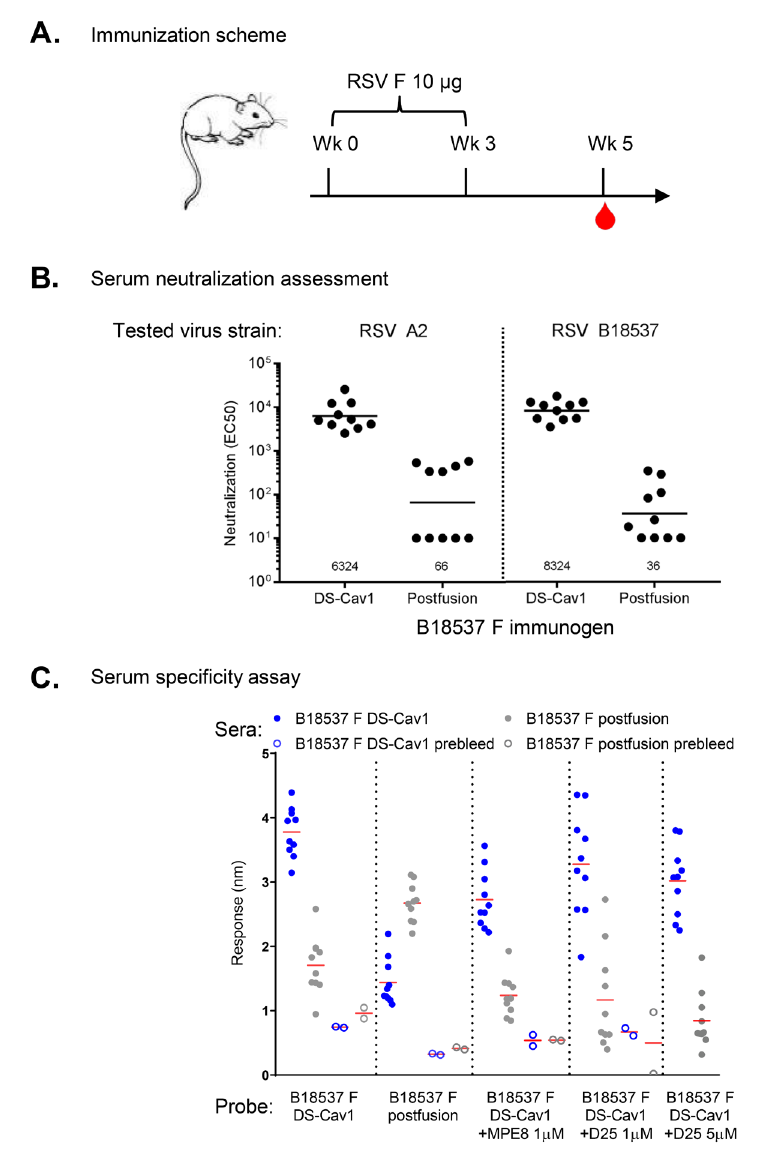
Figure 7. Prefusion-stabilized RSV B18537 DS-Cav1 F elicits high neutralization titers against both subtypes A and B viruses. (A) Mice were immunized with either DS-Cav1 or postfusion B18537 F glyco- protein at weeks 0 and 3. Serum samples were taken at week 5. (B) Mouse sera were assayed for neutral- ization against subtype A and B strains. Each dot represents the serum titer from a single mouse. Average titer of each group is marked with a line and also labeled on the horizontal axis. (C) Sera from mice immu- nized with RSV B18537 F prefusion DS-Cav1 or postfusion immunogen were assessed for binding to the immobilized RSV B18537 F DS-Cav1, postfusion, DS-Cav1 bound by MPE8, or DS-Cav1 bound by D25. Average response of each group is marked with a red line. Statistical analyses in (B) and (C) were calculat- ed by Mann-Whitney 2-tailed t test, ****: P <